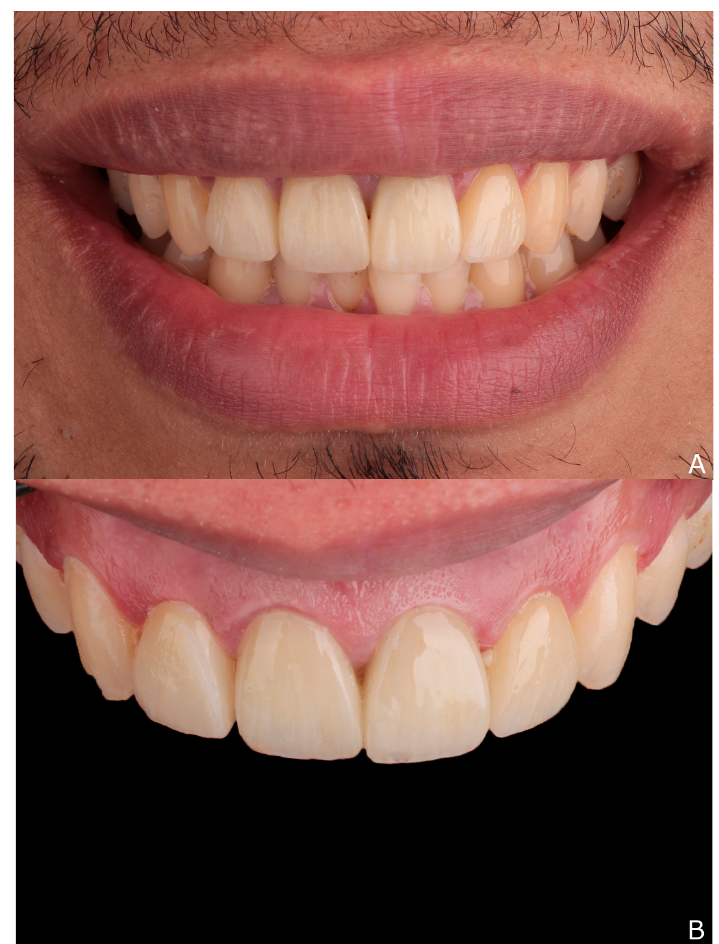
Figure 7. Steps of cementation: ( A ) clinical evaluation of fitting, surface texture and color matching; ( B ) isolation with split dam technique; ( C ) acid etching with 37% phosphoric acid; ( D ) bonding with universal